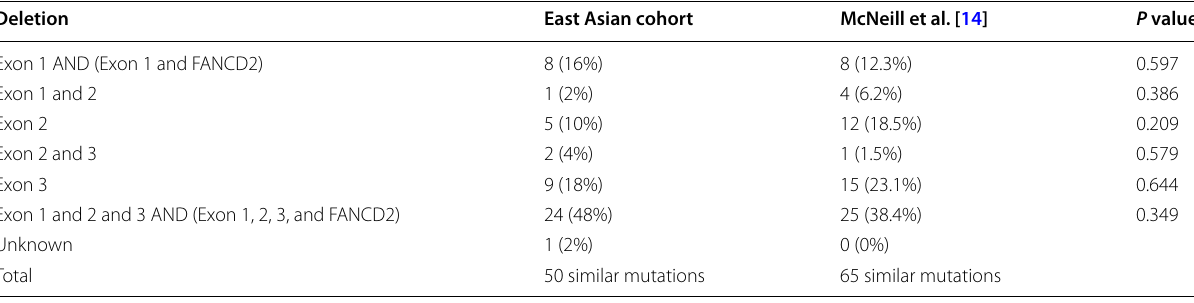
Table 2 Comparison of distribution of exon deletions in the VHL gene between East Asian and the cohort registered in Birmingham, United Kingdom